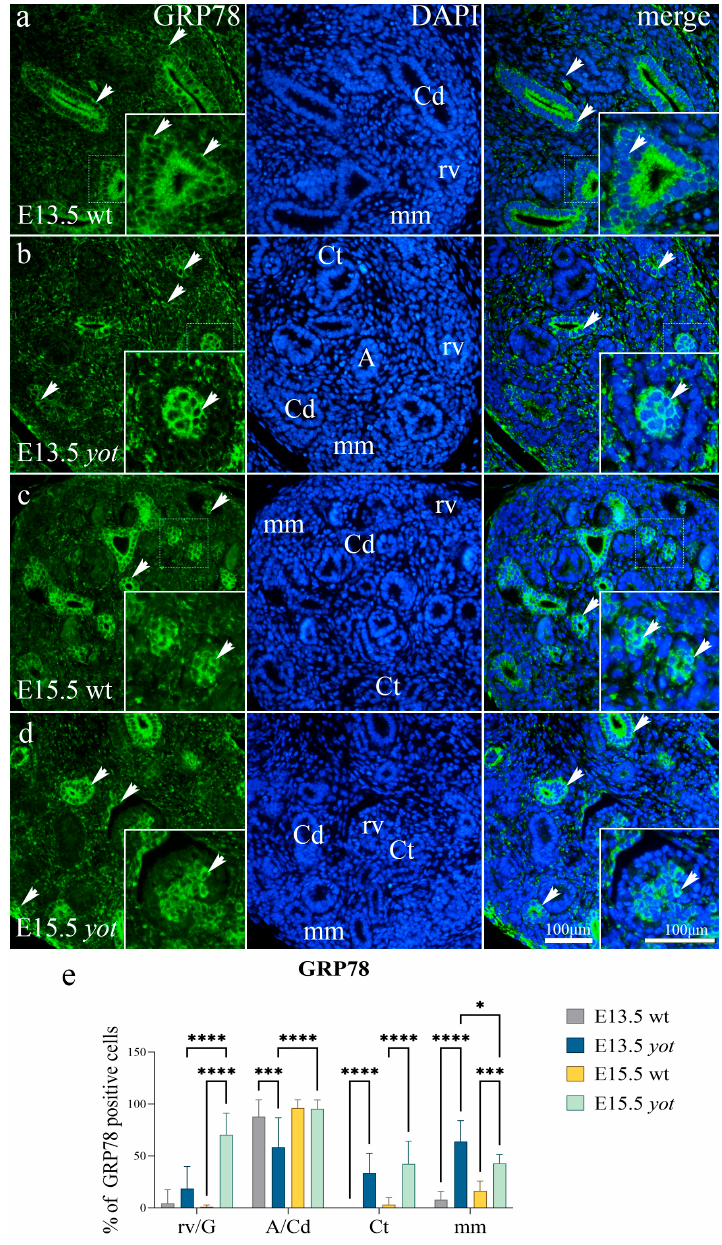
Figure 3. Immunofluorescence staining of developing wild-type (wt) ( a , c ) and yotari ( b , d ) mouse kidneys with GRP78 marker and DAPI nuclear staining. Three mice were used for each genotype ( yotari and wt) at every observed time point. Arrows show the expression pattern of GRP78 in the metanephric mesenchyme (mm), renal vesicles (rv), glomeruli (G), convoluted tubules (Ct), ampullae (A), and collecting ducts (Cd) indicated on the 4 ′ ,6-diamidino-2-phenylindole (DAPI) image. The most prominent protein expression area is shown in the inserts, corresponding to the dashed boxes. Images were taken at a magnification of ×40. The scale bar is 100 µm, which refers to all images. Graph ( e ) shows the distribution of the percentage of GRP78-positive cells in the metanephric mesenchyme (mm), renal vesicles (rv) or glomeruli (G), convoluted tubules (Ct), and ampulla (A) or collecting ducts (Cd) of wild-type and yotari kidneys at embryonic days E13.5 and E15.5. Data are presented as the mean ± SD (vertical line) and analyzed by a two-way ANOVA test followed by Tukey’s multiple comparison test. Significant differences are indicated by * p < 0.05, *** p < 0.0001, **** p < 0.00001. At each time point, ten substructures were assessed.